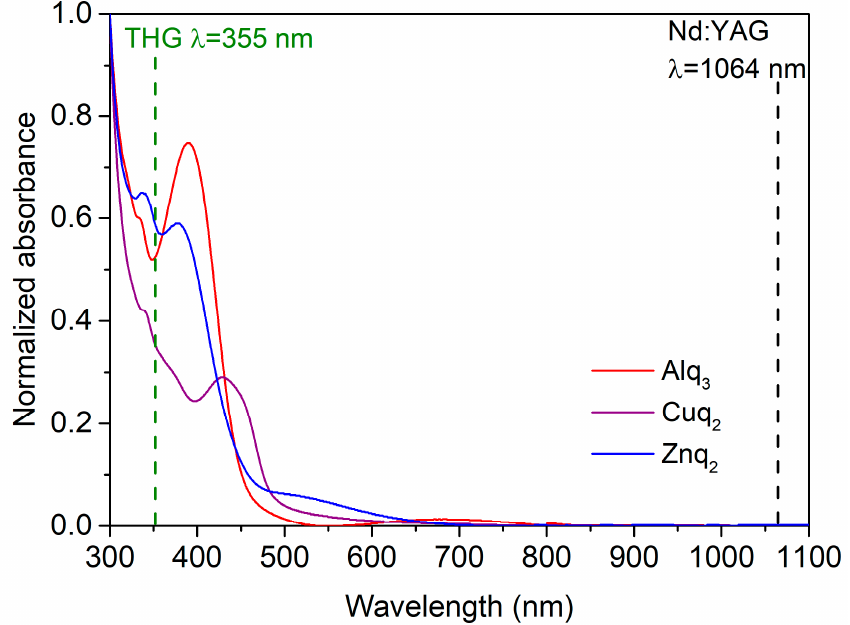
Figure 4. UV-Vis absorption spectra of studied molecules (Znq 2 , Cuq 2 , and Alq 3 ).